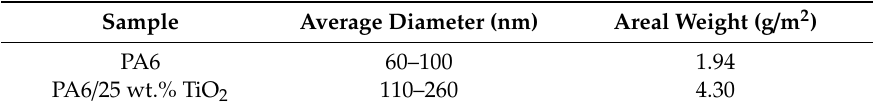
Table 1. Average diameter and areal weight of the PA6 and PA6 / 25 wt.% TiO 2 nanoparticle electrospun nanofibre